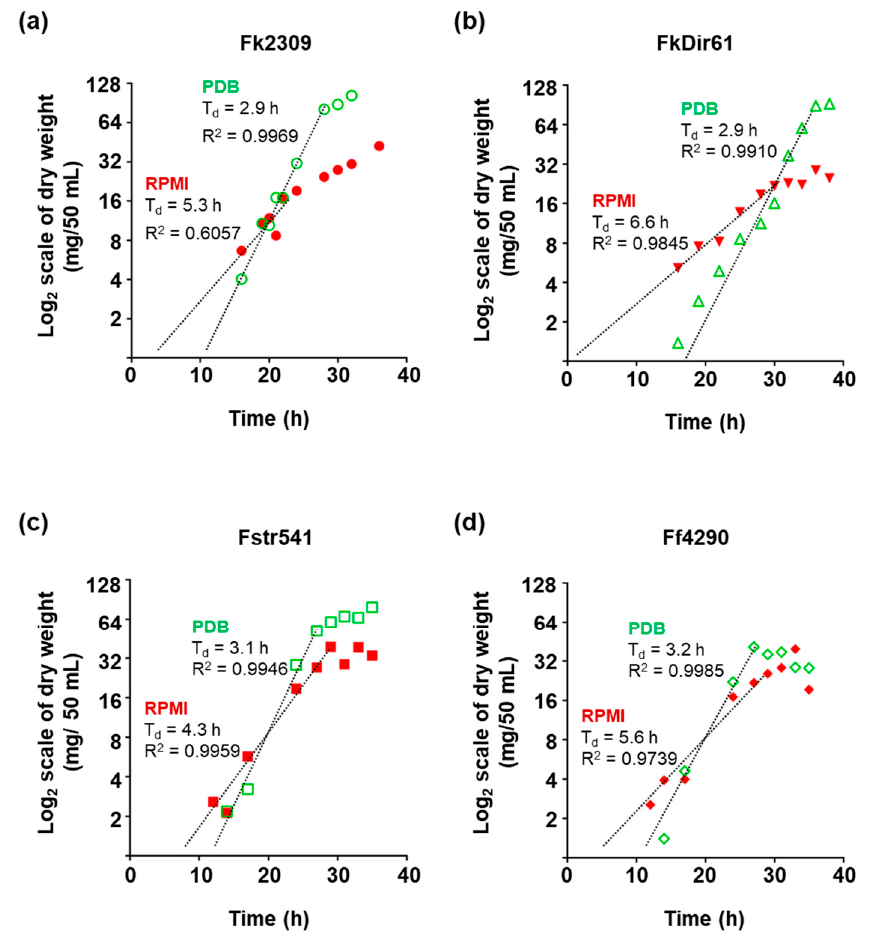
Figure 4. Growth curves of two F. keratoplasticum strains, Fk2309 ( a ) and FkDir61 ( b ), and of F. striatum and F. falciforme isolates Fstr541 ( c ) and Ff4290 ( d ) grown in PDB (green circles) or RPMI (red circles) medium, respectively. Dotted lines are the trendlines for the exponential growth phase that were used to calculate the generation time (T d ). The results presented were from a single experiment.